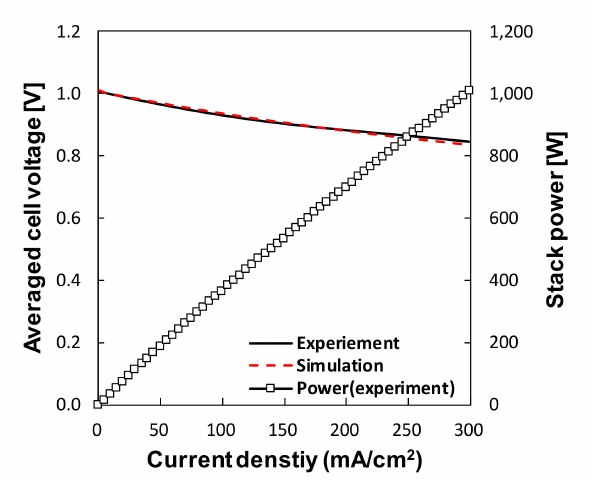
Figure 2. Comparison between the predictions and experimental data.